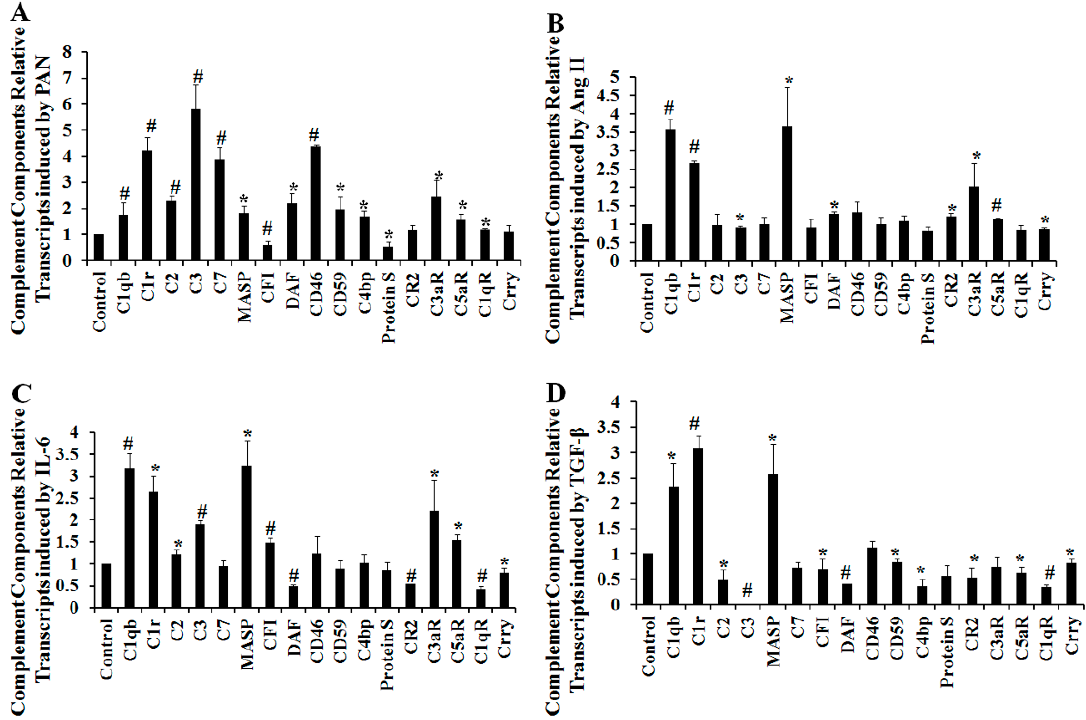
Figure 2. The effect of stimulation by various factors on complement gene expression. Cultured immortalized podocytes were treated with 50 μ g/mL puromycin aminonucleoside (PAN) ( A ); 10 − 6 M angiotensin II (Ang II) ( B ); 100 ng/mL interleukin-6 (IL-6); ( C ) or 5 ng/mL transforming growth factor- β (TGF- β ) ( D ). Complement gene expression was quantitatively analyzed using quantitative real-time RT–PCR or conventional RT-PCR. Data are presented as means ± SD. n = 3. * p < 0.05 vs. control group; # p < 0.01 vs. control group.